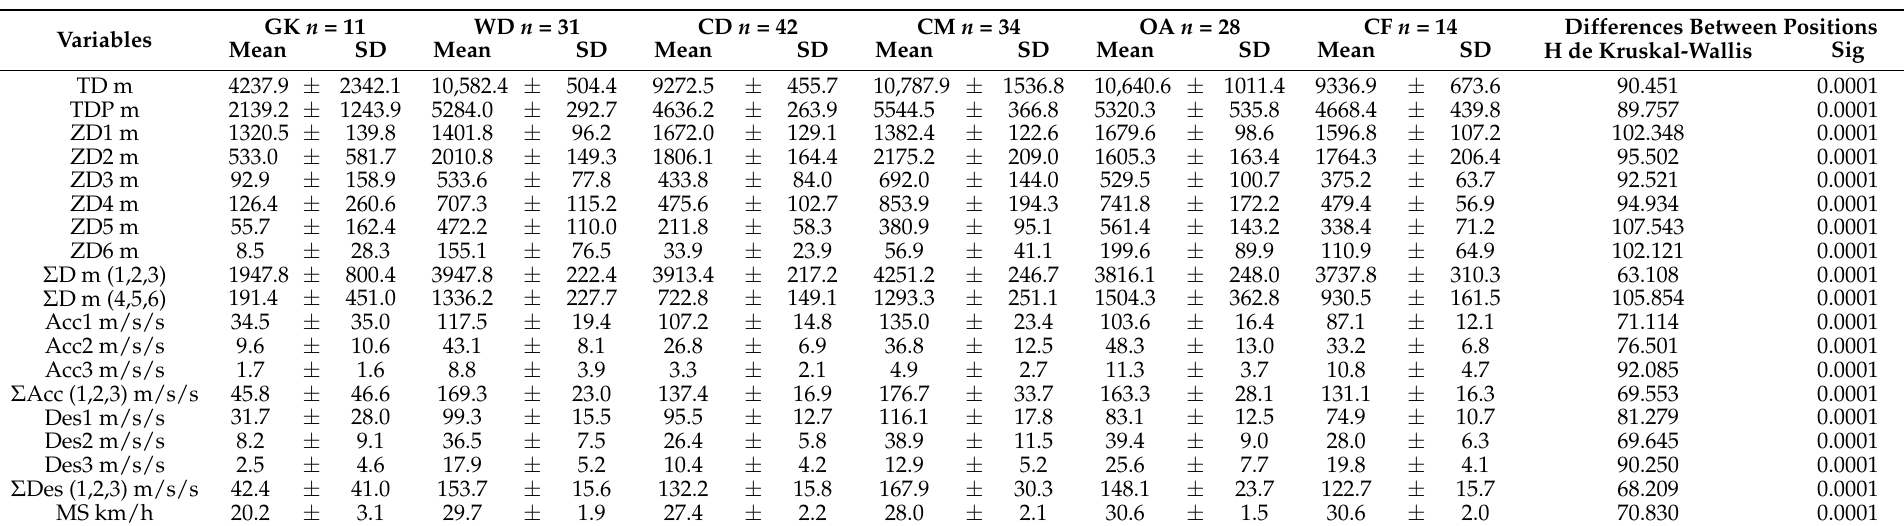
Table 2. Distances covered across each speed threshold according to each playing position (Data are reported as mean ±